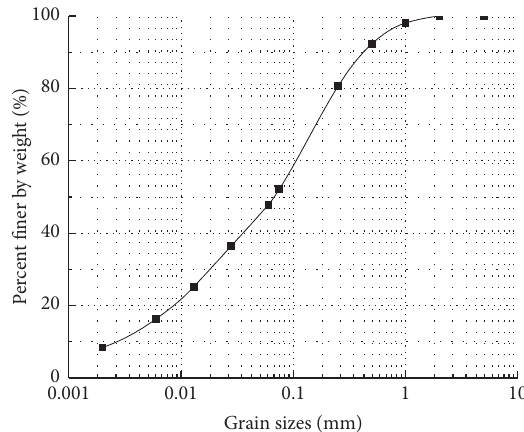
Figure 2: Grain size distribution of the tested